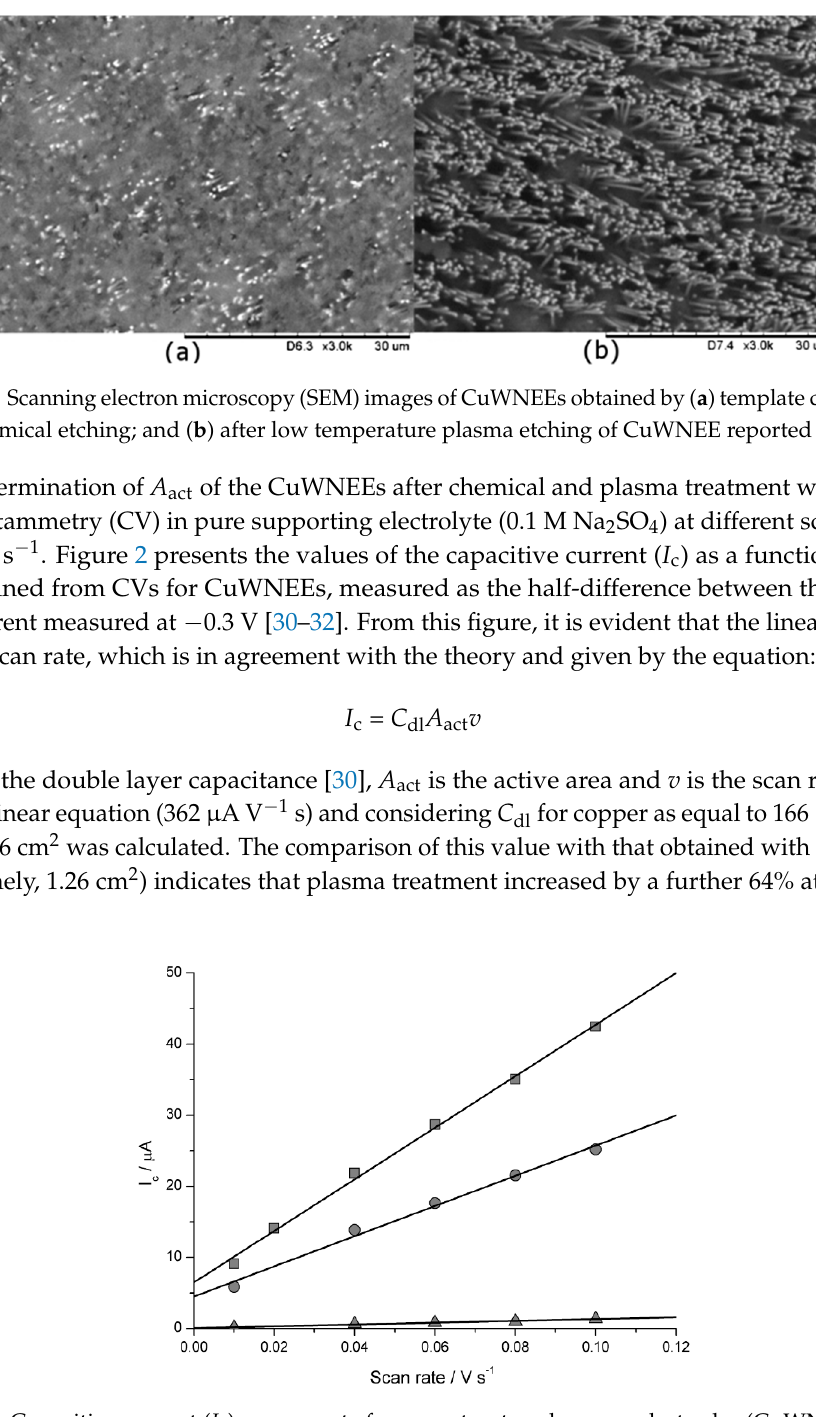
Figure 2. Capacitive current ( I c ) vs scan rate for nanostructured copper electrodes (CuWNEE) after chemical and low-temperature plasma etching ( ), after only chemical etching ( ) and flat (CuE) copper electrode ( ).